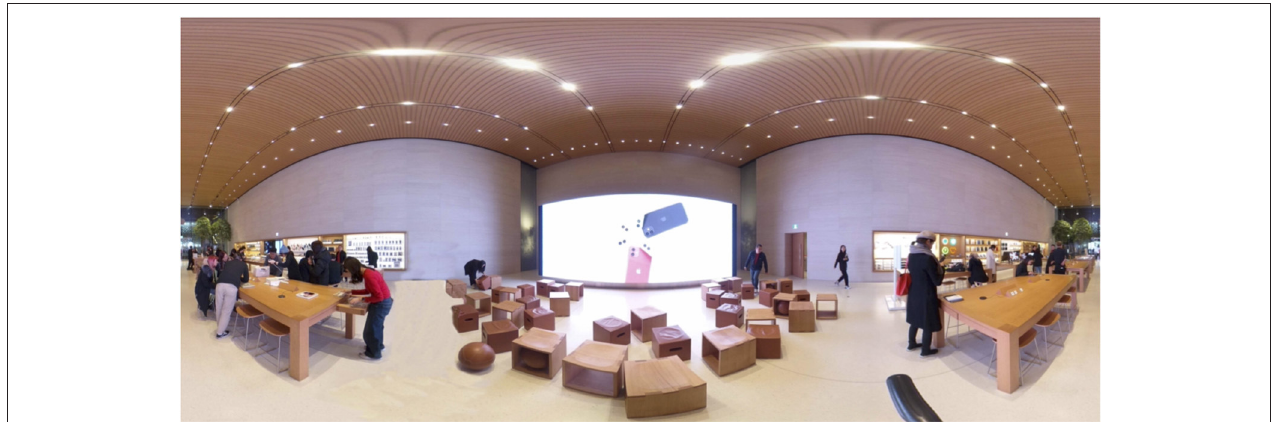
FIGURE 2 | 360 ◦ panoramic image of Stimulus 2.